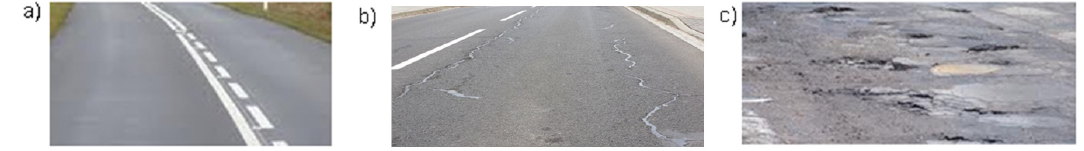
Figure 2. The example of the road surface classified in the paper as: ( a ) A good, ( b ) B slightly damaged, ( c ) C bad.